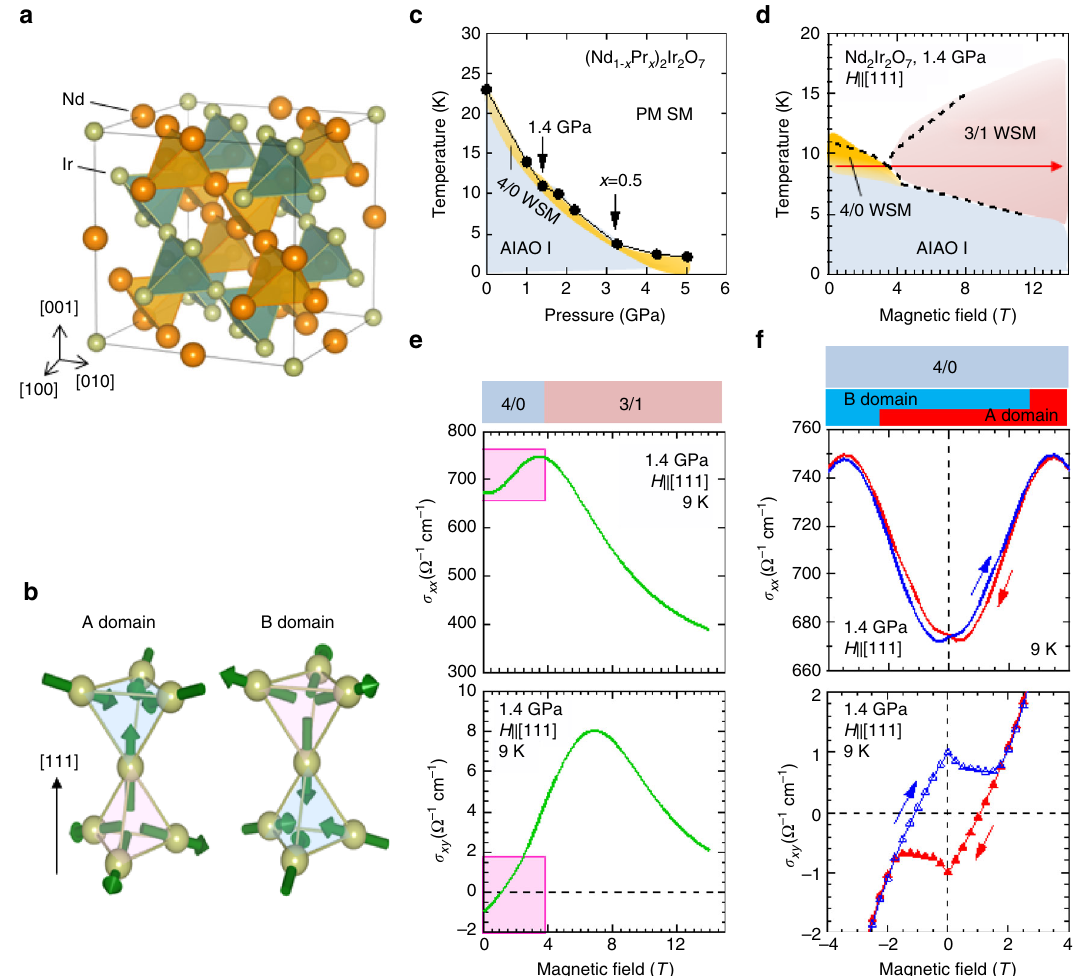
Fig. 1 Phase diagram and representative magnetic transport properties in R 2 Ir 2 O 7 . a Pyrochlore lattice structure. Orange balls depict Nd ions and green ones are Ir ions. b Schematic magnetic con fi guration of all-in all-out state for A domain (left) and B domain (right). Phase diagram of (Nd 1- x Pr x ) 2 Ir 2 O 7 in the plane of c temperature and external pressure, d temperature and magnetic fi eld at 1.8 GPa. According to the previous study 22 , the chemical substitution of Nd ions with Pr ones effectively scales with the external pressure P , i.e., “ chemical pressure ” . In Fig. 1c, we apply pressure on R = Nd while the x = 0.5 composition under ambient pressure corresponds to P = 3.3 GPa. PM SM stands for paramagnetic semimetal, 4/0 WSM stands for 4-in 0-out (all-in all- out) Weyl semimetal, AIAO I for all-in all-out insulator, 3/1 WSM for 3-in 1-out Weyl semimetal, respectively. e Magnetic fi eld dependence of